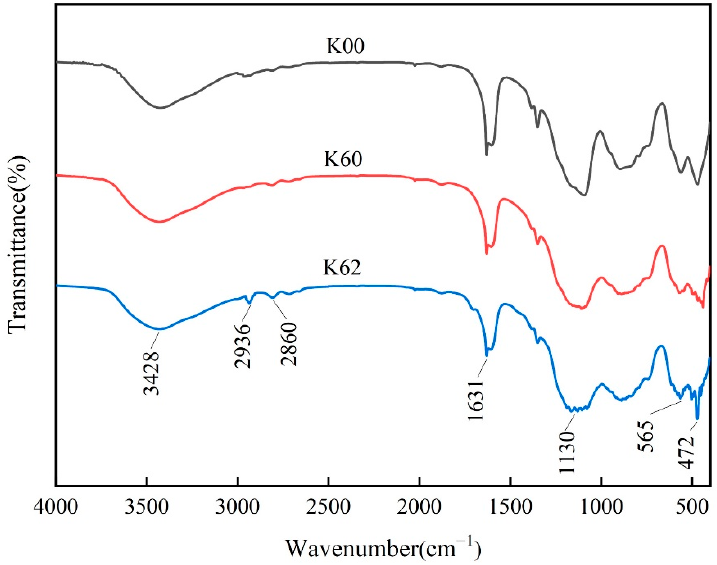
Figure 8. FT-IR spectra of kaolin before and after modi fi cation.